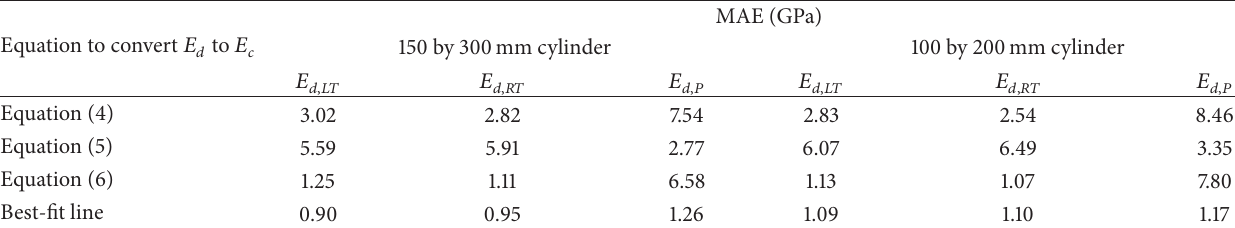
Table 4: Mean absolute error (MAE) of expressions relating static and dynamic elastic modulus measured using 100 by 200 mm and 150 by 300 mm